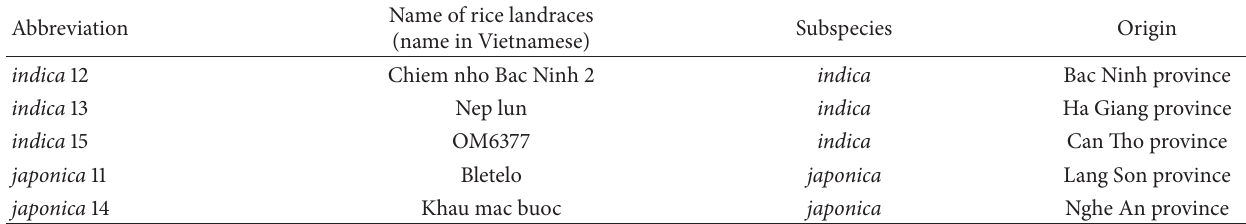
Table 1: Abbreviation list of Vietnamese rice genomes used in the